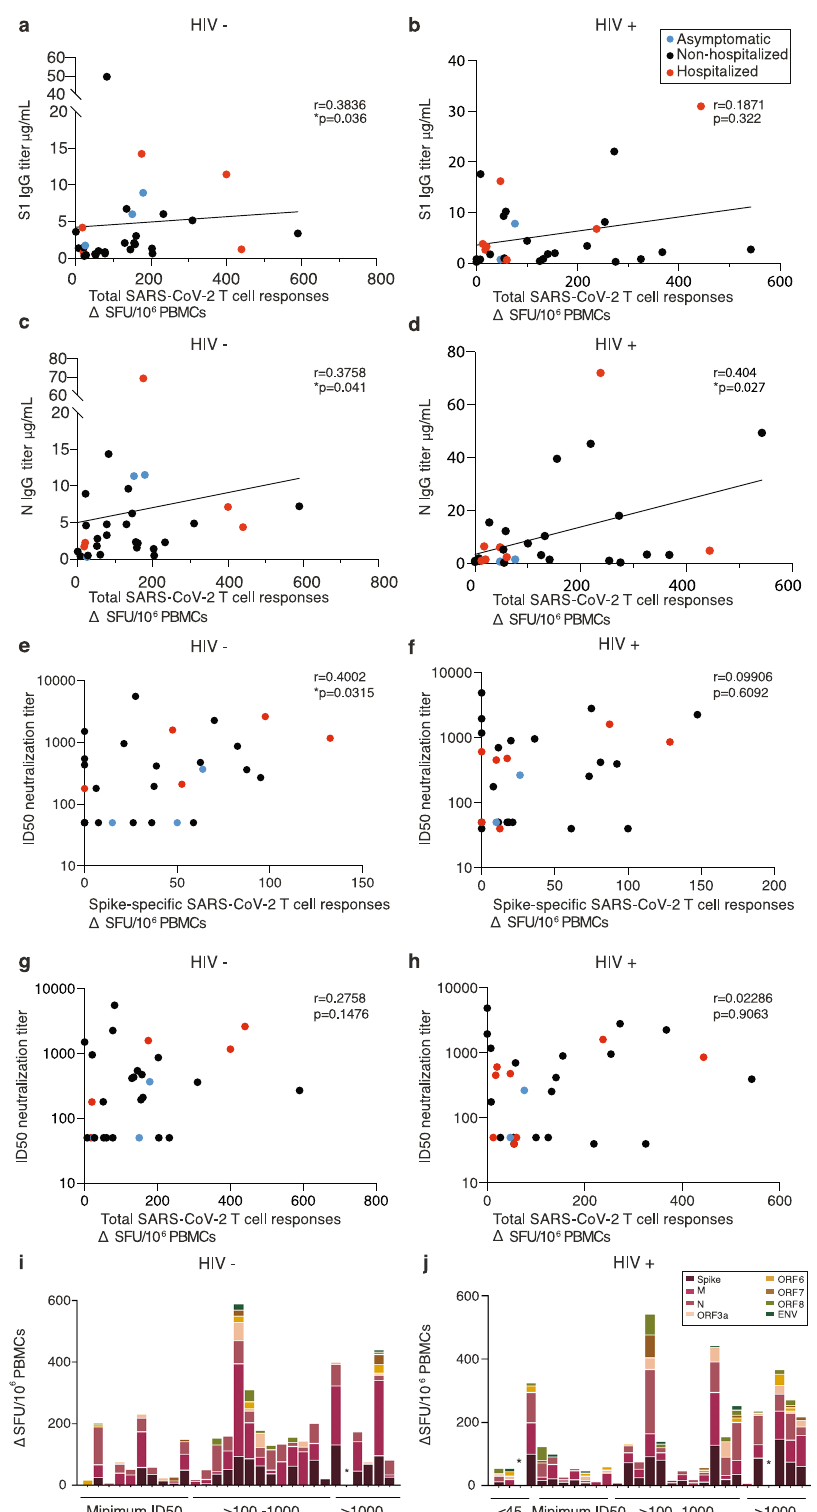
Fig. 3 Interrelations between T-cell and antibody responses in HIV-positive and -negative donors. a Correlation of total SARS-CoV-2 responses with S1 IgG titers in HIV negative and b HIV positive. c Correlation of total SARS-CoV-2 responses with N IgG titers in HIV-negative and d HIV-positive subjects. Red dots: hospitalized cases; black dots: non-hospitalized cases. e Correlation of neutralization titers with Spike-speci fi c SARS-CoV-2 responses in HIV- negative and f HIV-positive donors. g Correlation of neutralization titers with total SARS-CoV-2 responses in HIV-negative and h HIV-positive donors. i Hierarchy of the T-cell responses ordered by the neutralizing capacity by their antibody titers in HIV-negative and j HIV-positive donors. The non- parametric Spearman test was used for correlation analysis. Two-tailed * p <